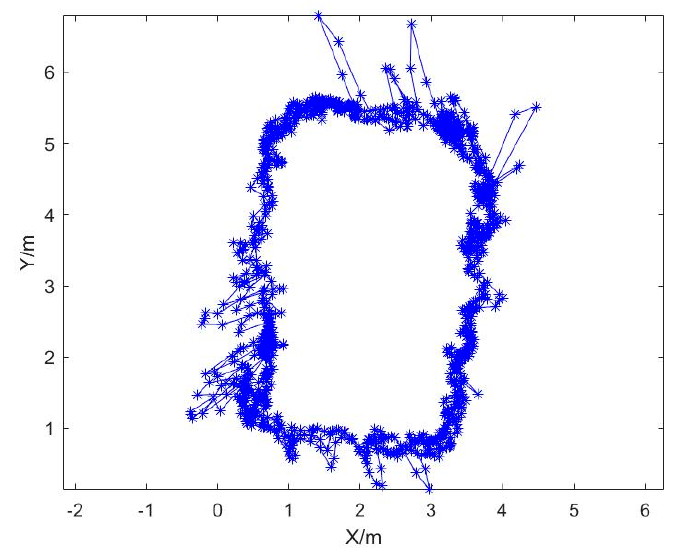
Figure 6. The UWB positioning results.